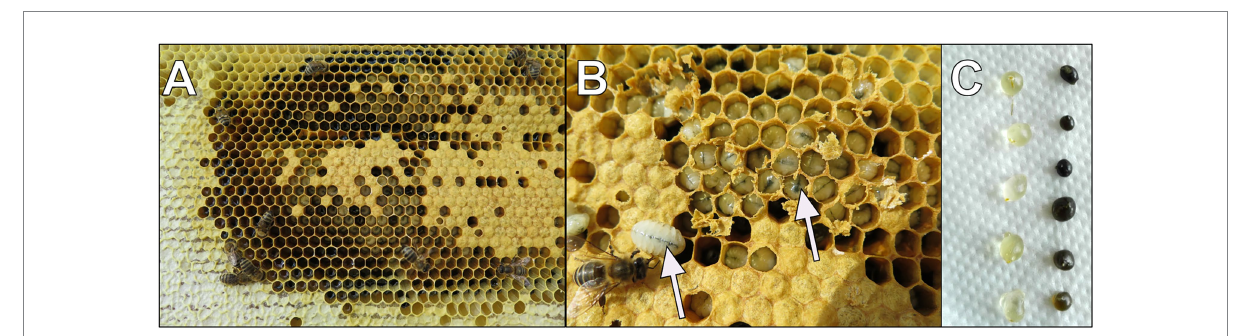
FIGURE 7 Documentation of the consumption of Chlorella in experimental hives. (A) Example of stored Chlorella syrup in wax combs; (B) Green color of the larval midgut due to Chlorella syrup consumption marked with arrows; (C) Honey crops dissected from adult bees with a visible green color in Chlorella fed group (right